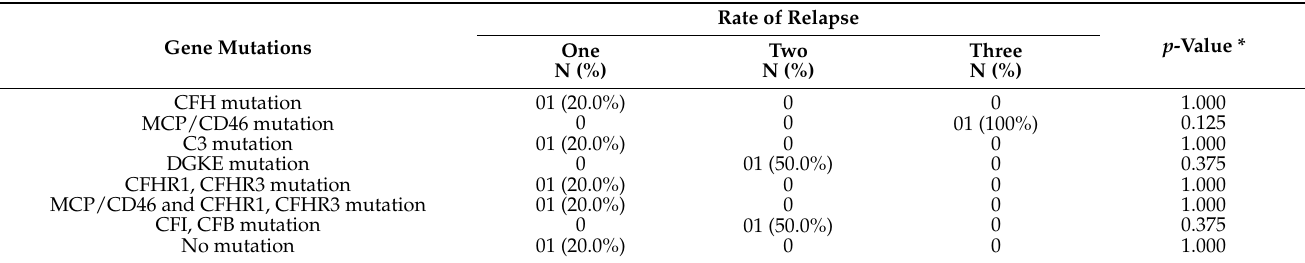
Table 4. Rates of relapse according to gene